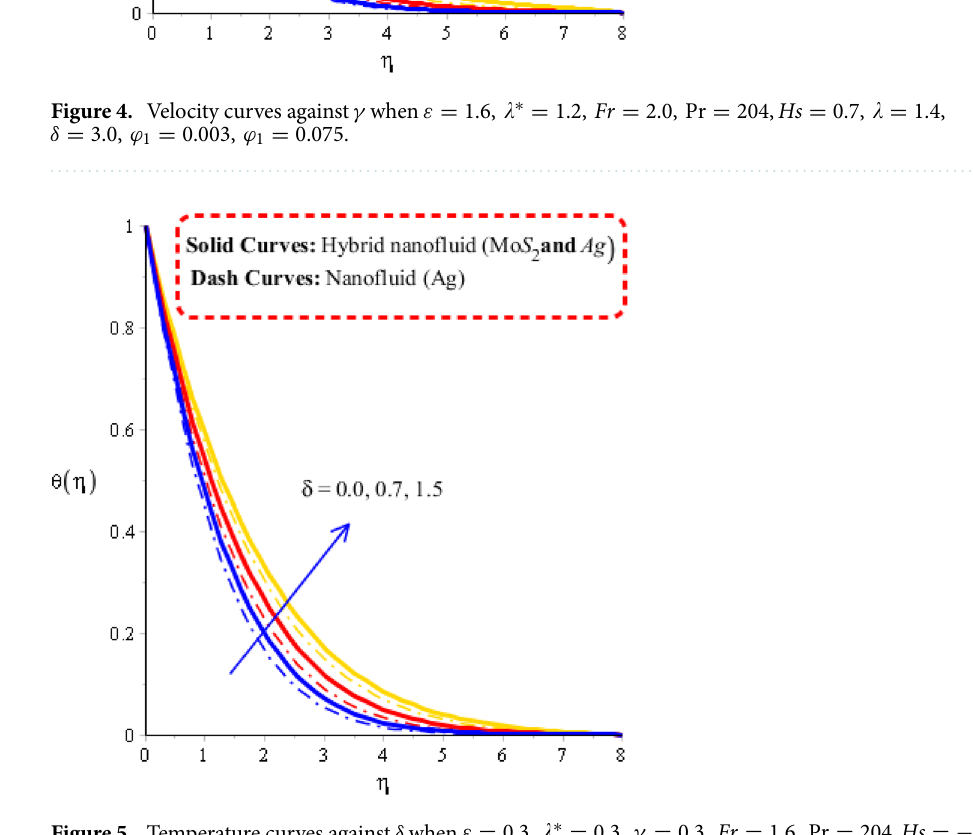
Figure 5. Temperature curves against δ when ε (cid:31) = 1.3, ϕ 1 = 0.003, ϕ 1 =